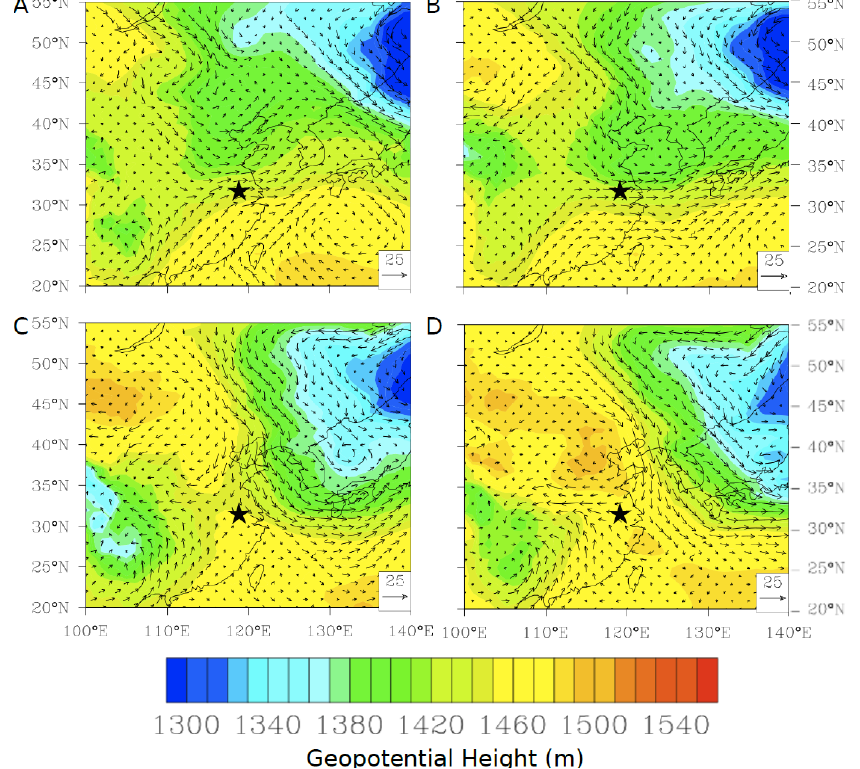
Figure 4. Geopotential Height maps of East Asia at the 850 mbar level from NCEP/NCAR reanalysis data. The maps show: ( A ) 12:00 UT, 7 February 2011, ( B ) 0:00 UT, 8 February 2011, ( C ) 12:00 UT, 8 February 2011, ( D ) 0:00 UT, 9 February 2011. The star (  ) indicates the location of